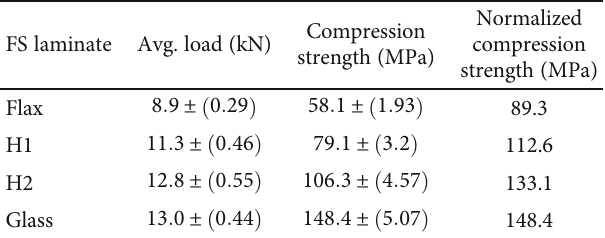
Figure 9: Failure mode of sandwich structures through edgewise compression. Table 4: Edgewise compression force and strength of the composite sandwich structure.